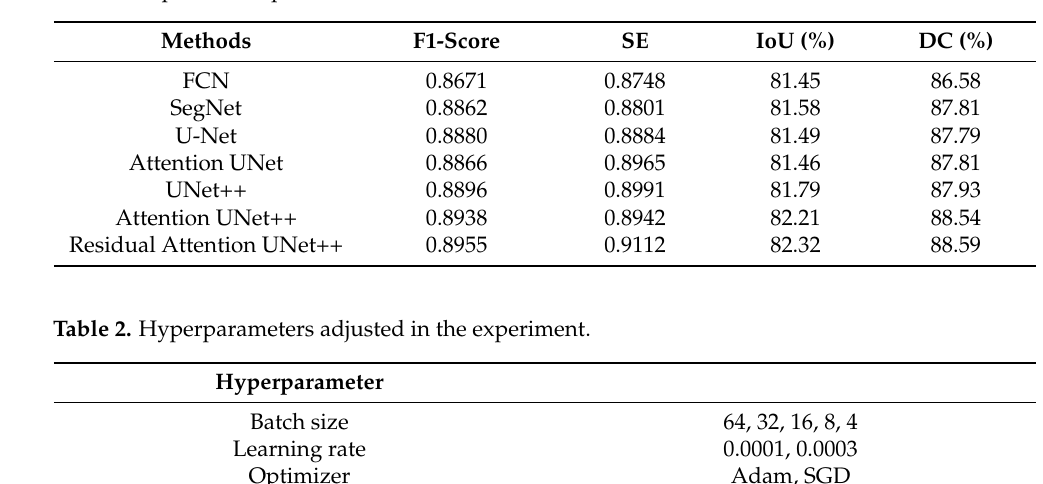
Table 1. Experimental performance of Residual-Attention UNet++ and other methods on skin datasets.